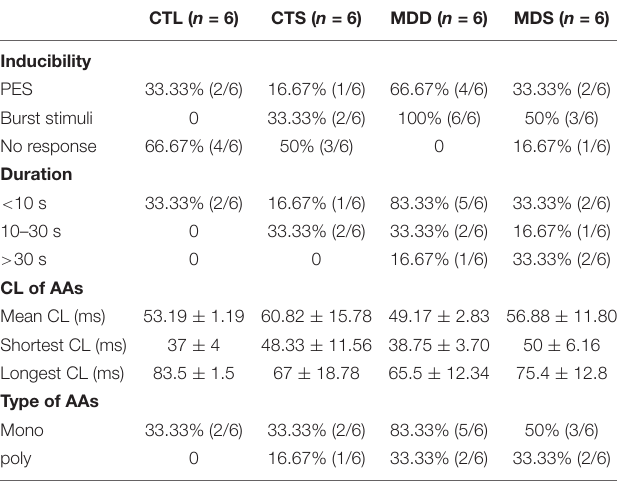
TABLE 1 | Incidence of AAs induced by PES or burst